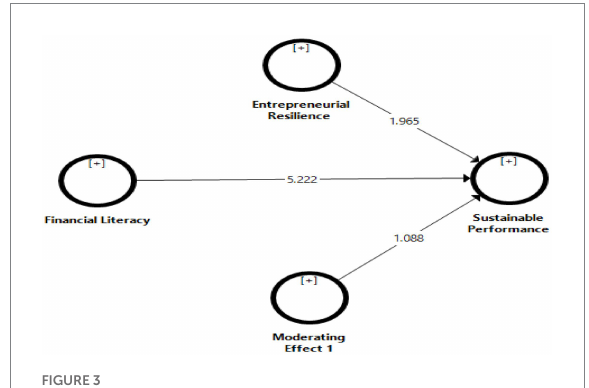
FIGURE 3 Bootstrapping. Authors’